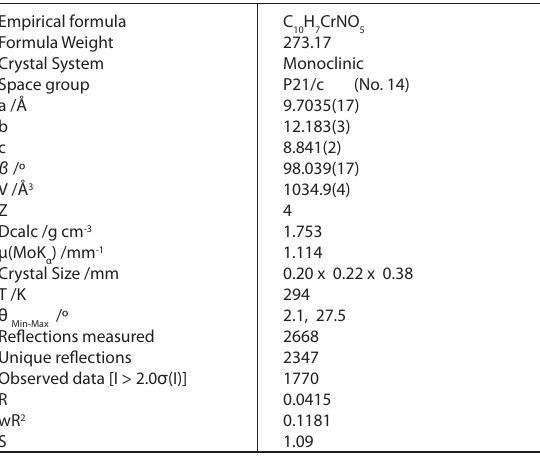
Table 1. Crystal data and structure refinement for (quinolinium-3- Empirical